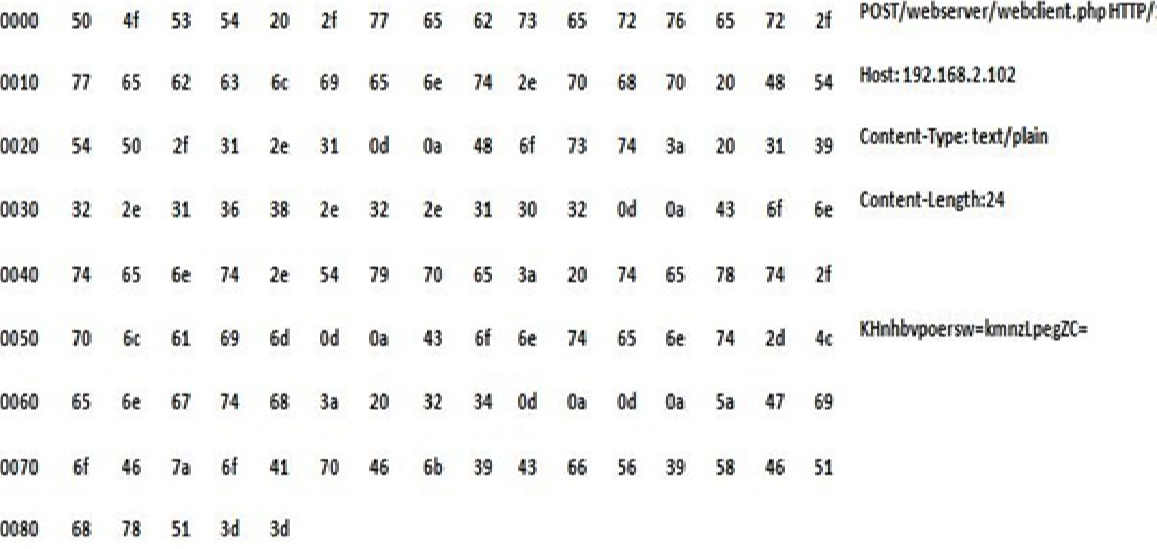
Figure 7. TCP Captured Packet from Attached Sensor Device